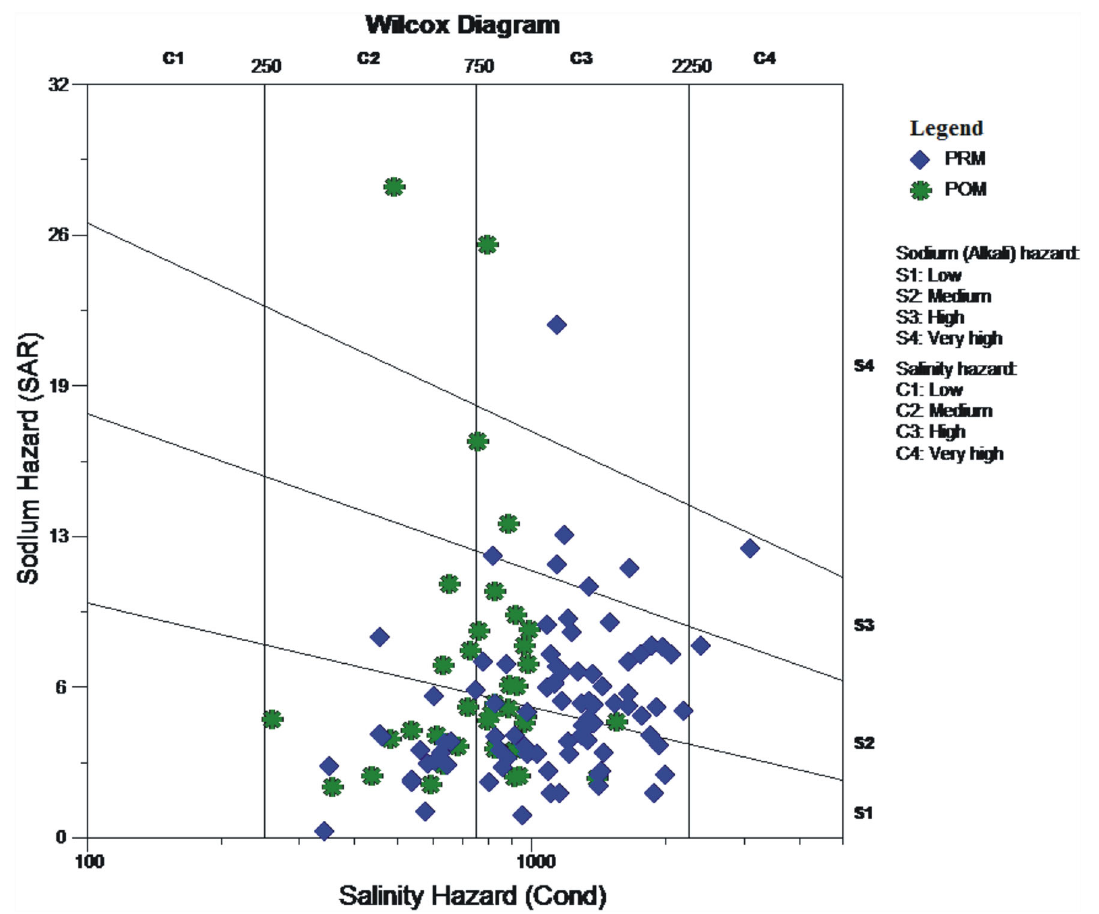
Fig. 15 Classification of irrigation water based on sodium hazard and salinity